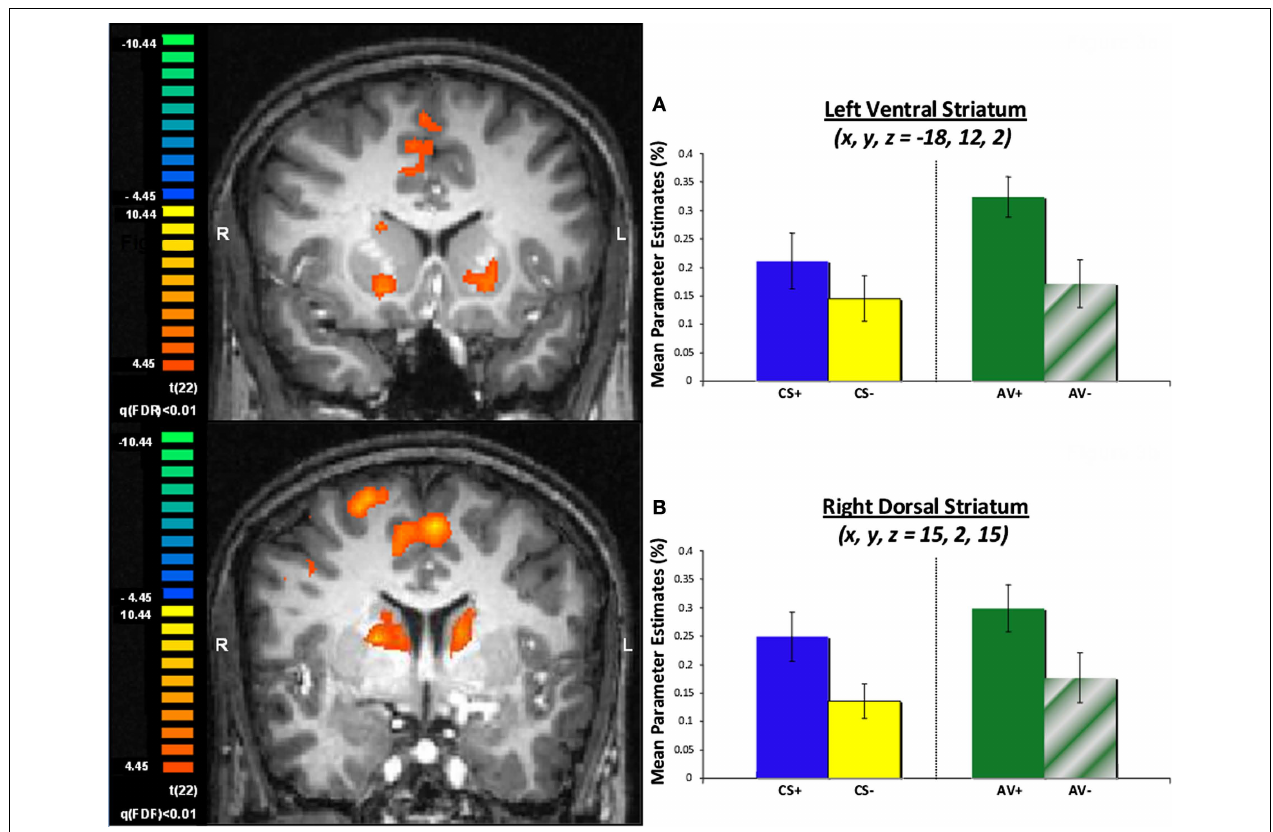
FIGURE 3 | Striatum ROIs defi ned by a contrast of aversive (CS + and AV + ) and safe (CS − ) trials. (A) BOLD signals in the left ventral striatum are depicted as mean parameter estimates and highlight differential response pre (AV + ) and post (AV − ) learning of an avoidance response. (B) BOLD signals in the right dorsal striatum displayed as mean parameter estimates also showing a differential response pre (AV + ) and post (AV − ) learning of an avoidance